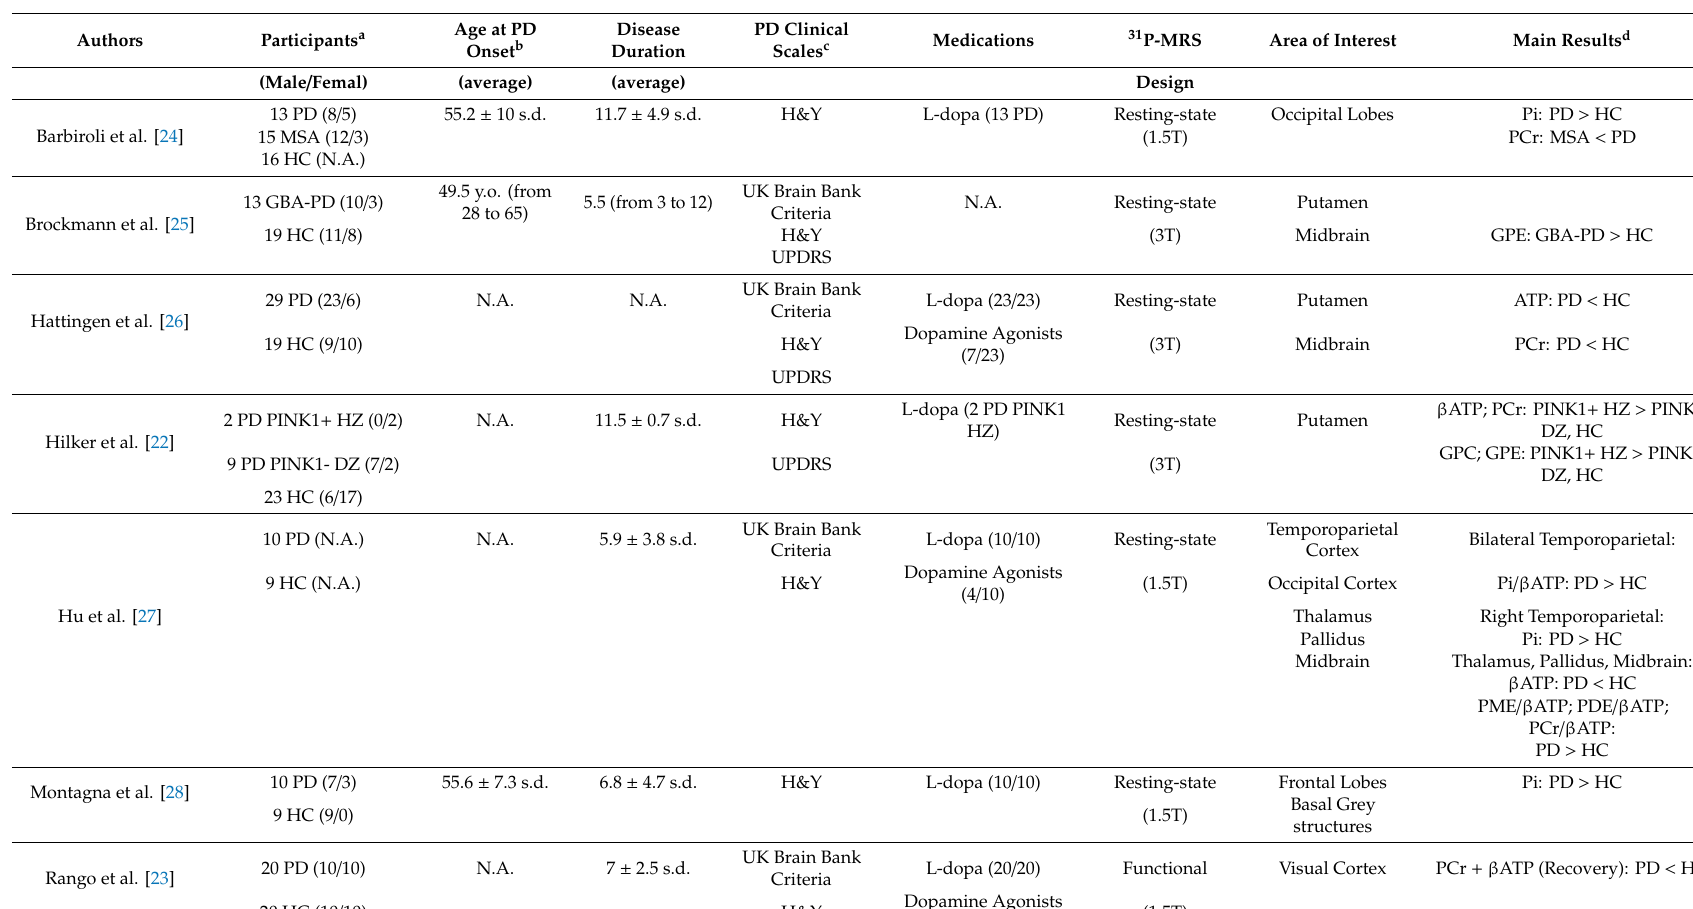
Table 1. Demographic and clinical characteristics of the 31 phosphorus magnetic resonance spectroscopy (P-MRS) studies included in the review (alphabetical